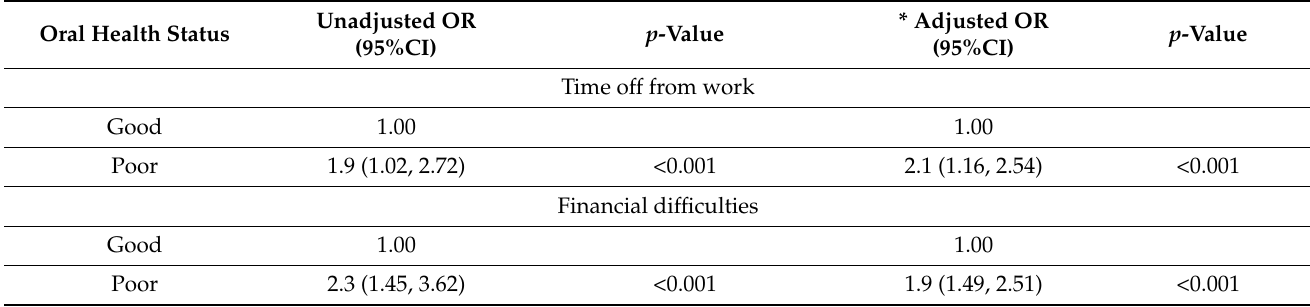
Table 5. Logistic regression models demonstrating the impact of poor oral health status of children on selected items in the family impact scale ( n =